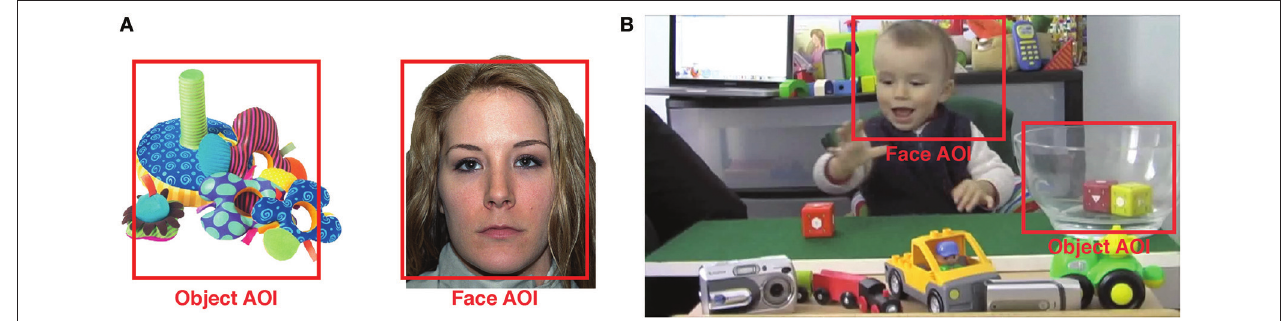
FIGURE 1 | Examples of the stimuli used to assess attention to faces using (A) static images, and (B) dynamic video. Red squares show Areas of Interest (AOI) used for analyses. Note that (A,B) in this figure are not displayed on the same scale. The face in a is taken from the NimStim set (Tottenham et al., 2009), the image of the child in b is used with written permission by both parents of the